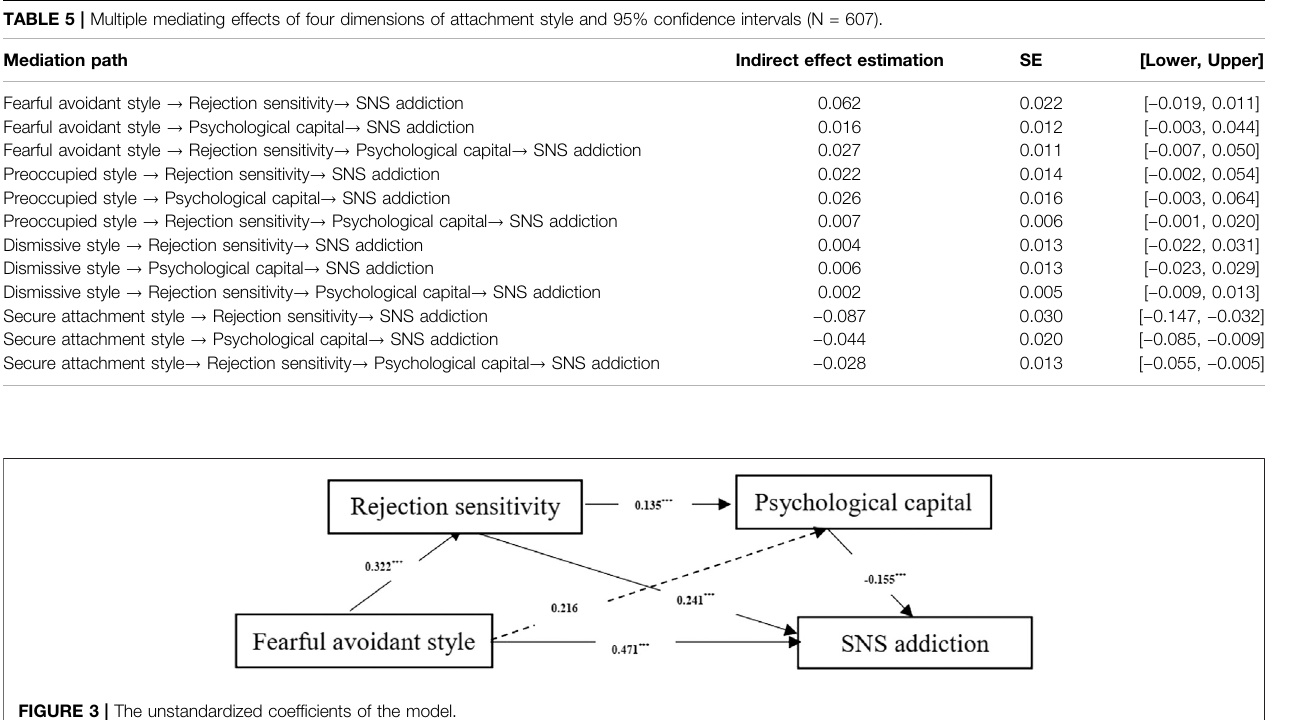
Figure 2 . All the paths were signi fi cant, except the trail from attachment styles to SNS addiction. Table 4 and 5 present the mediation analysis results of four dimensions of attachment style with demographic variables as covariates. While controlling for age and gender as demographic variables, we tested psychological capital and rejection sensitivity as multi-chain mediators between each dimension of attachment style and SNS addiction. According to the data analysis, the multiple mediations of the fearful-avoidant style on SNS addiction is signi fi cant, and the mediated effect size is 0.027 accounting for 8.11% of the total prediction effect. The total